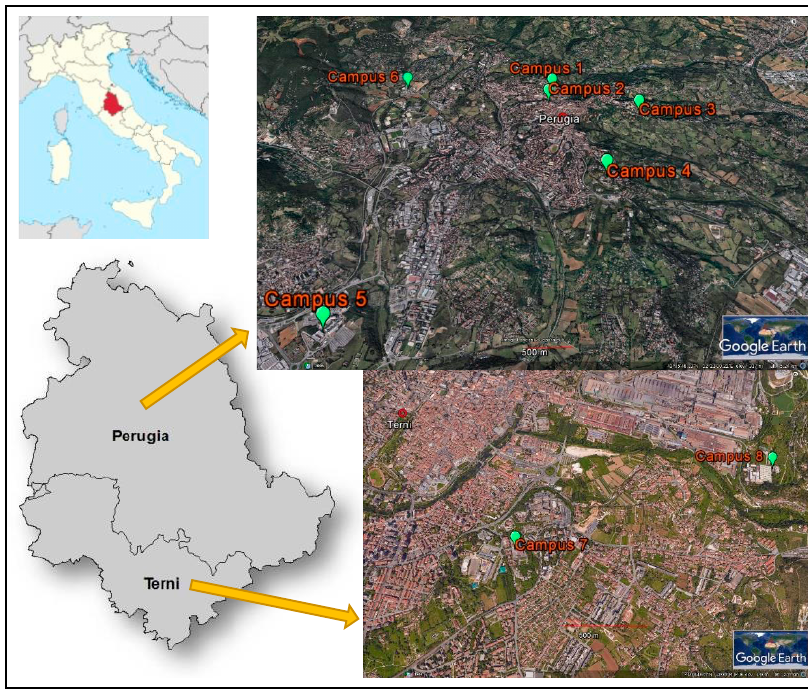
Figure 1. Location of the eight campuses of the University of Perugia.